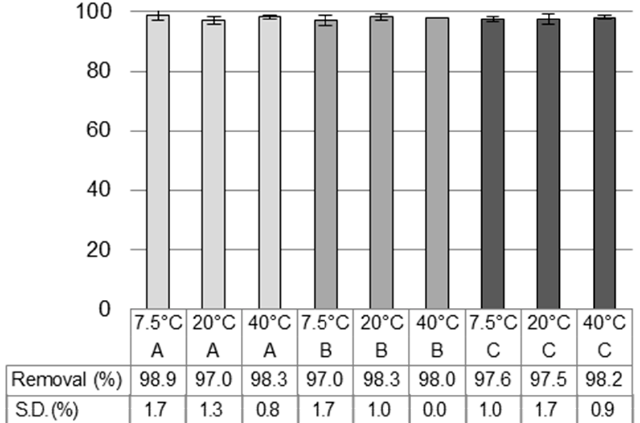
Figure 2. Removal efficiency for 100 mg mixture of PE/PP (1:1) from 1 L demineralized water at different temperatures using 100 μ L organosilane (A = PE ‐ X; B = n ‐ Butyltrichlorosilane; C = Iso ‐ octyltrichlorosilane).